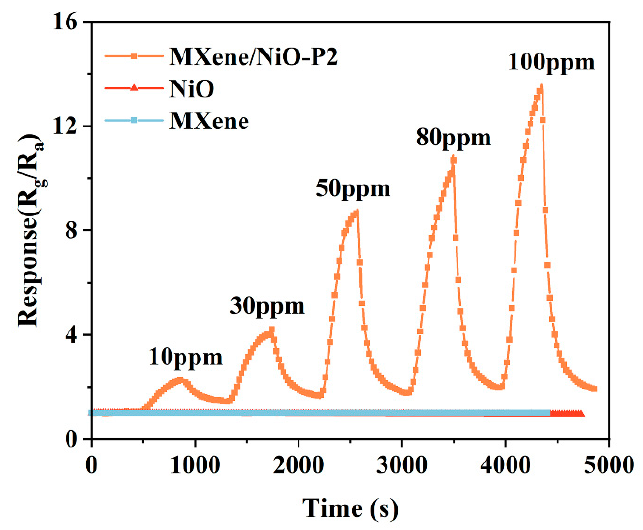
Figure 7. Response changes in the sensors based on MXene/NiO-P2, MXene, and NiO to 10–100 ppm HCHO at 25 °C.